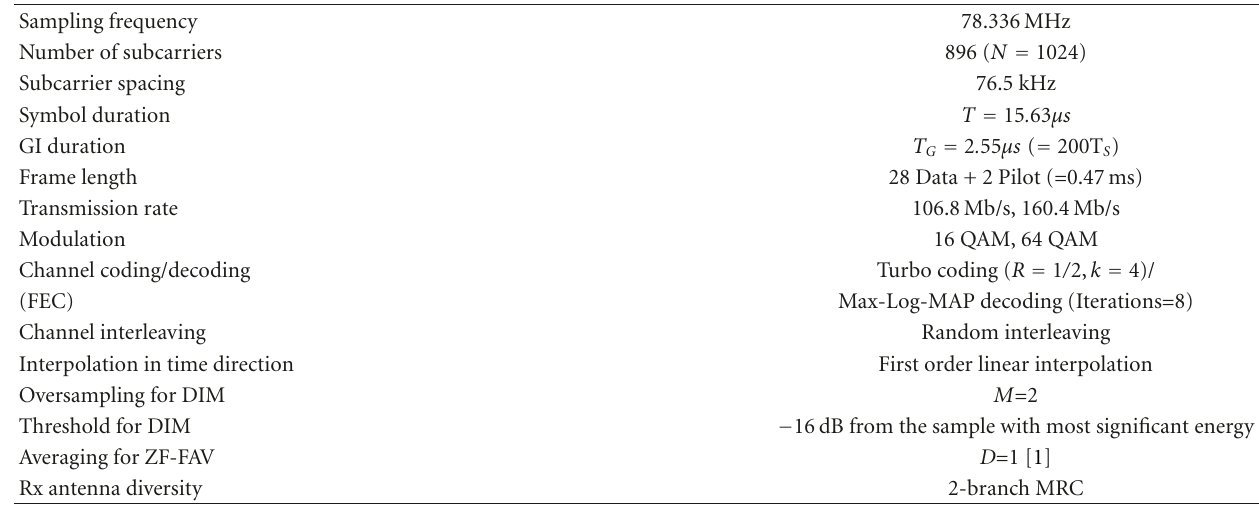
Table 1: Simulation parameters.